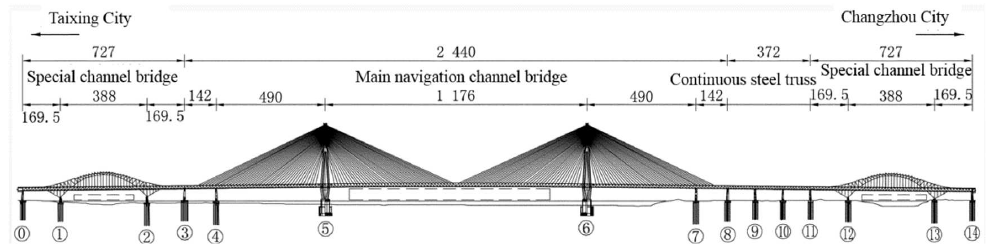
Figure 1. Main Bridge of Changtai Yangtze River Bridge.